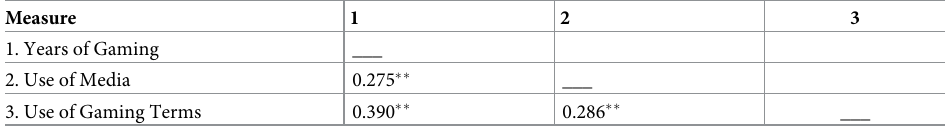
�� Correlation is significant at 0.01 level (2-tailed).